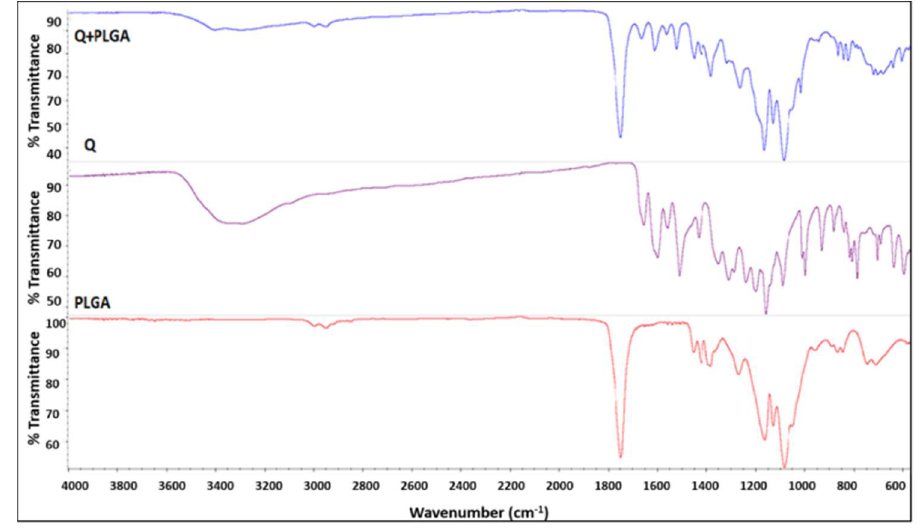
Figure 2. FT-IR spectra of Q-PLGA.